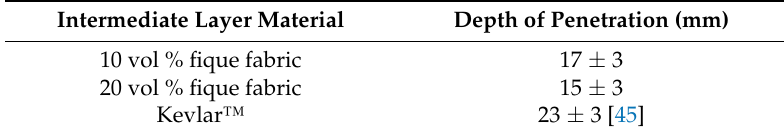
Table 1. Average depth of penetration in the clay witness backing different MAS of fique fabric composites.